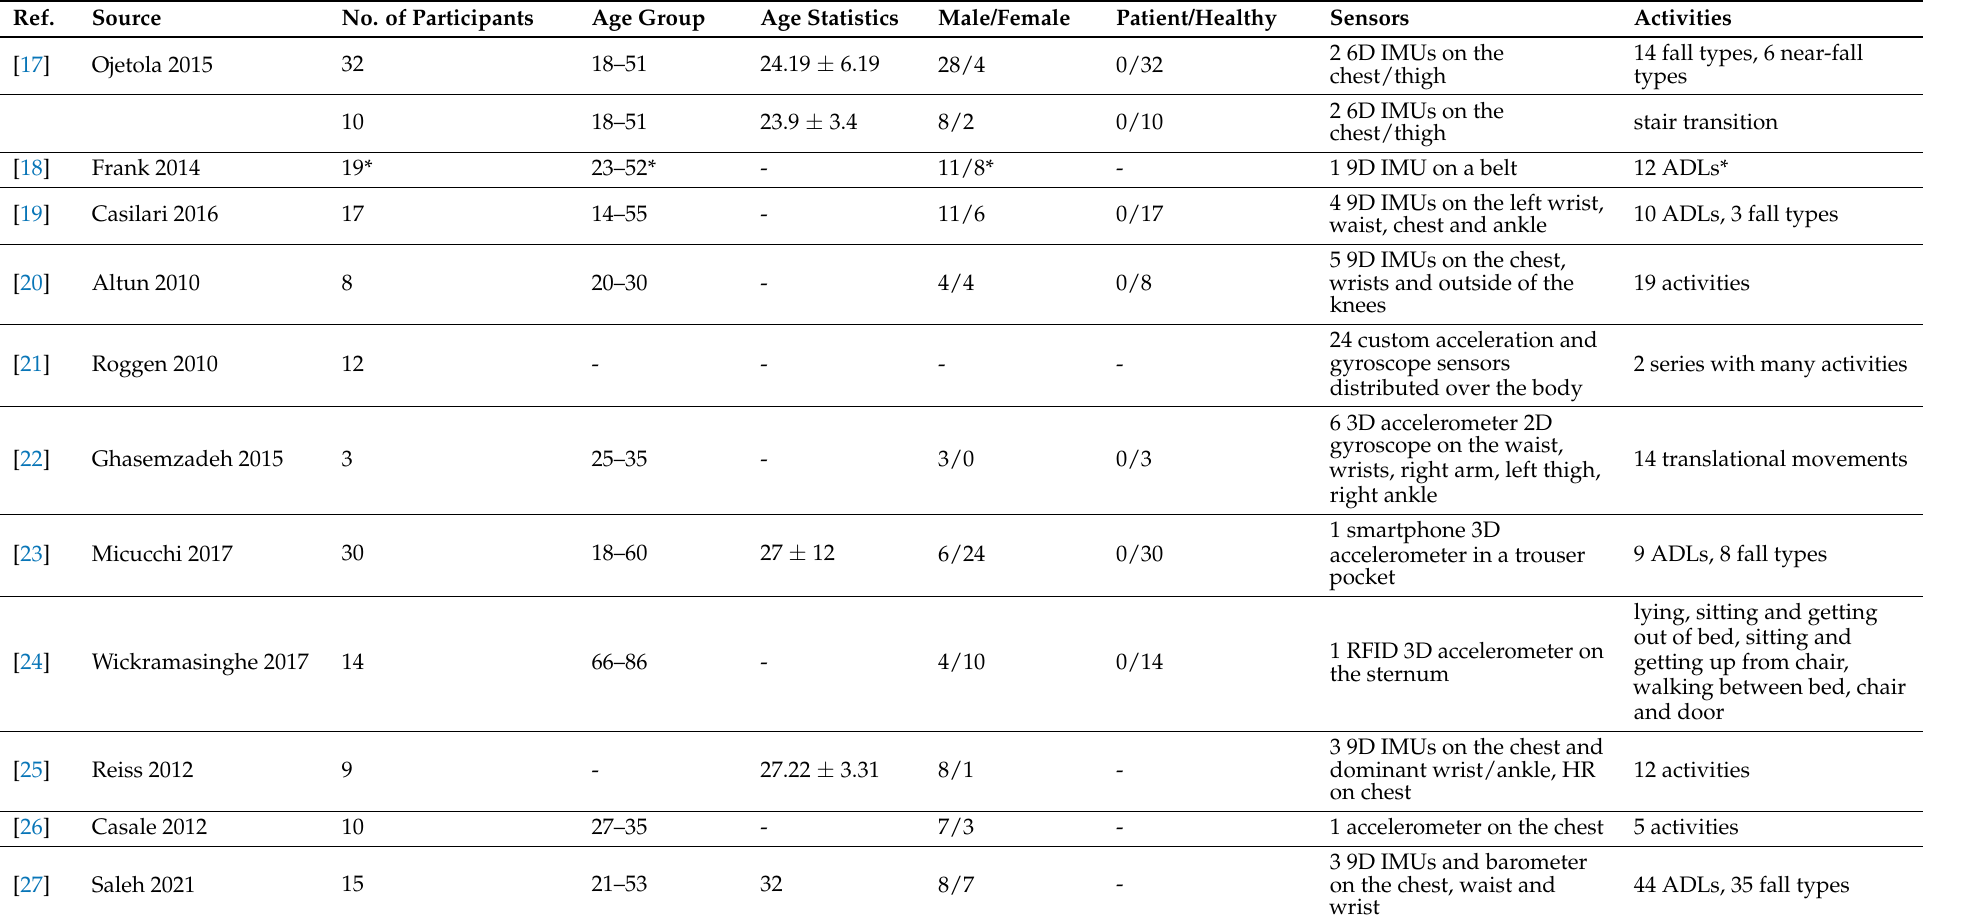
Table A2. Information on demographics and study characteristics provided in the datasets. * = information in source differs from information presented within the dataset, the numbers presented are from the